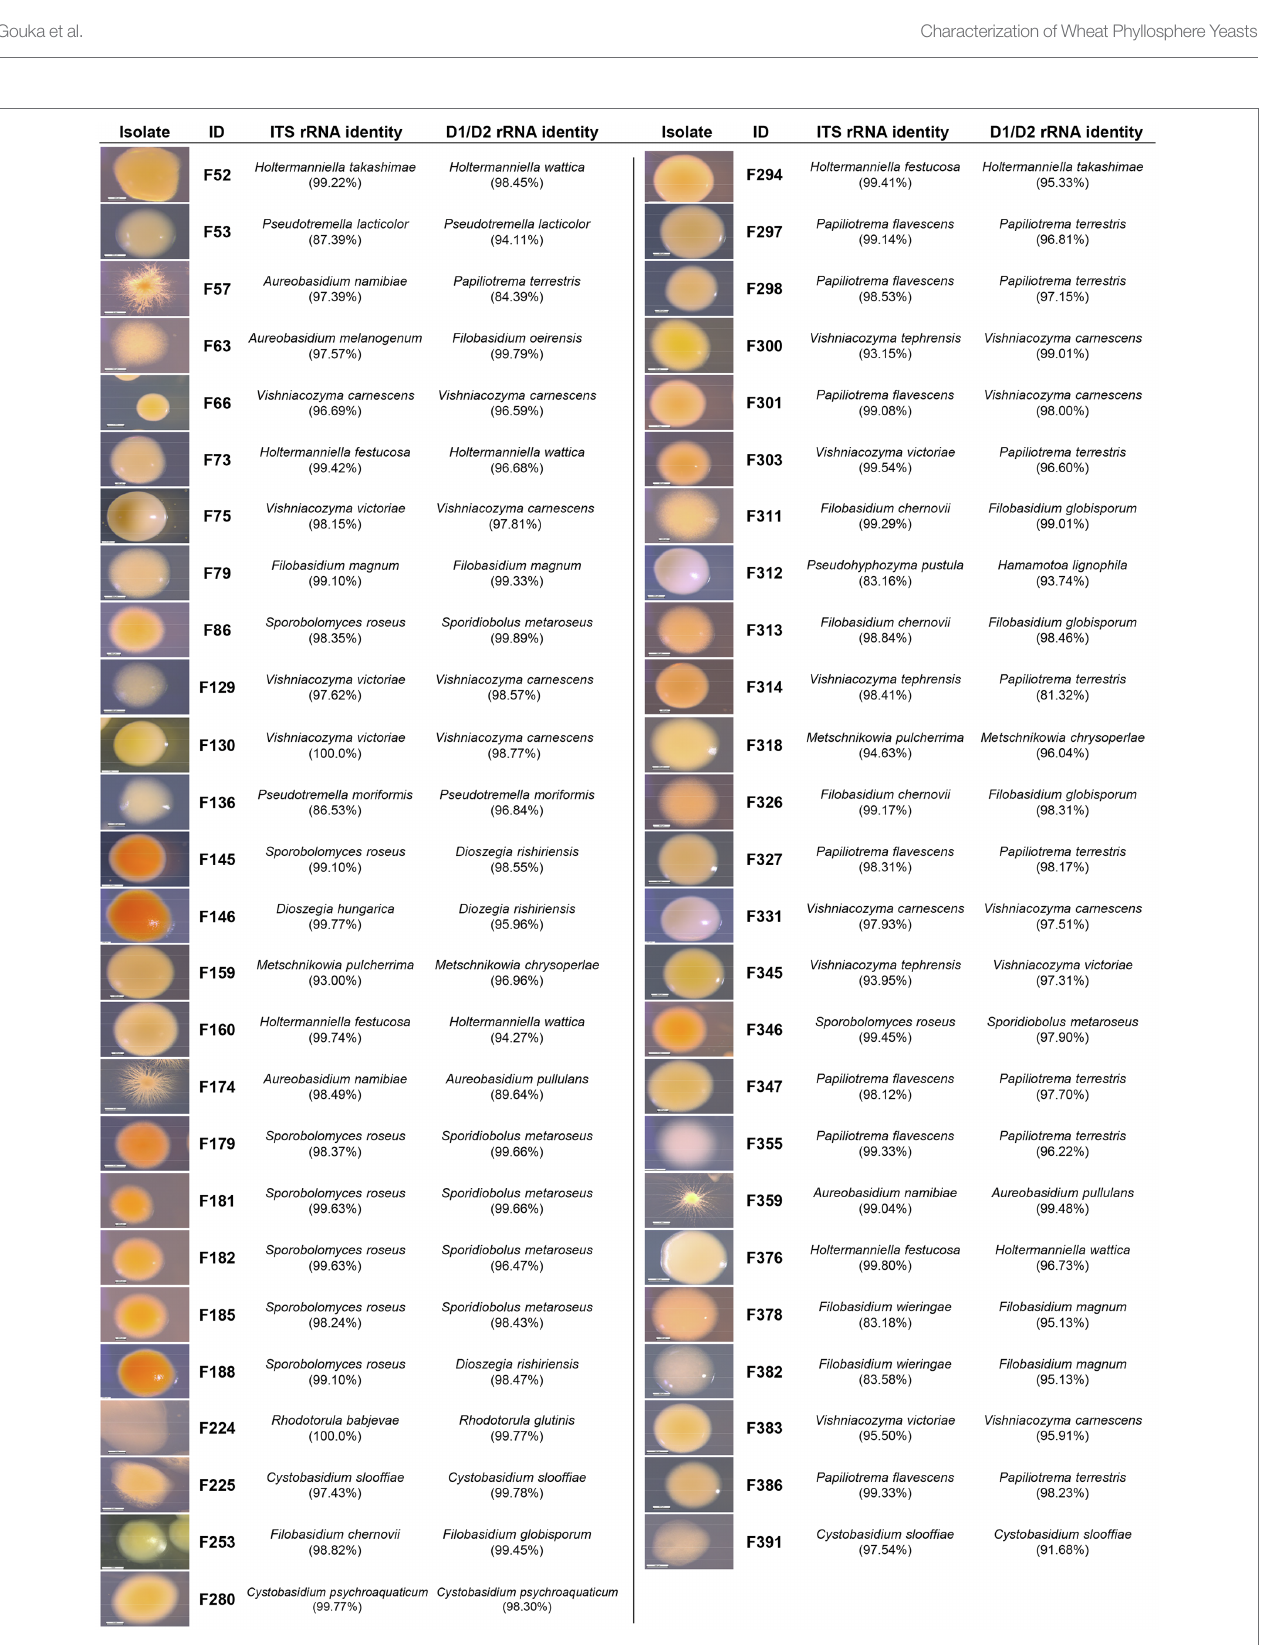
FIGURE 2 | Phenotypic and taxonomic characterization of the selected yeast isolates. Pictures depict 5 to 10-day-old isolates grown on PDA at 25 ° C. Partial ITS and D1/D2 rRNA gene sequences were compared to the NCBI database for taxonomic